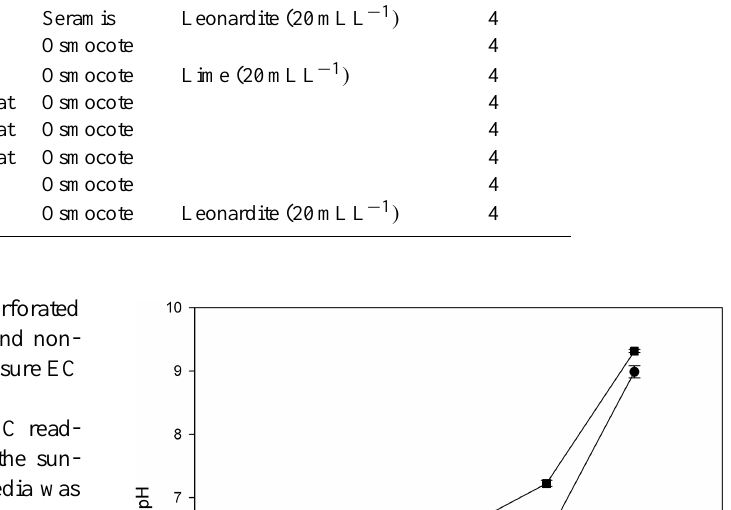
Table 2. Treatments and experimental setup. Growing media Fertilization Additives Replicates ( n ) Experiment 1 Seramis Perlite